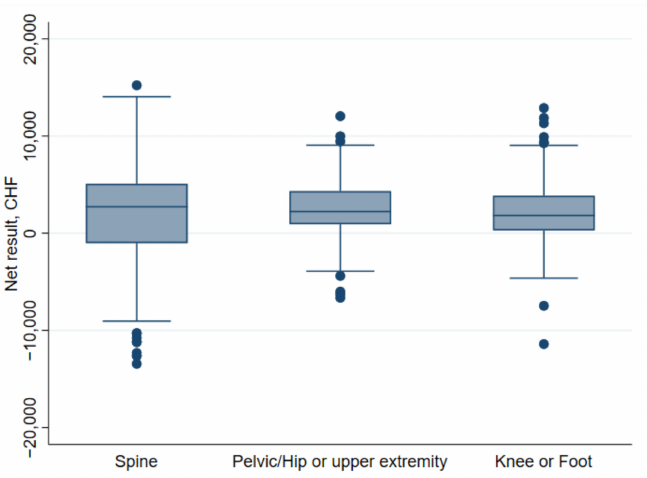
Figure 10. Box plot of net financial results according to surgical